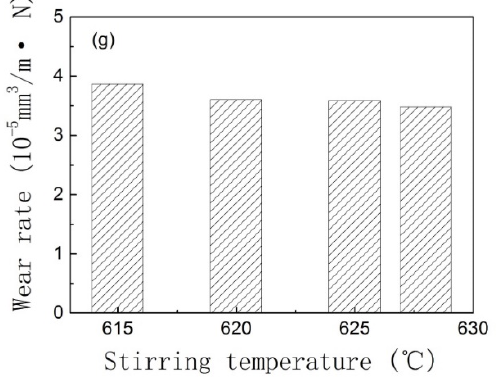
Figure 2. Friction coefficient, weight loss and wear rate of the rheoformed composite parts at different semisolid stirring temperatures: ( a ) friction coefficient at 615 °C, ( b ) friction coefficient at 620 °C, ( c ) friction coefficient at 625 °C, ( d ) friction coefficient at 628 °C, ( e ) average friction coefficient, ( f ) weight loss and ( g ) wear rate.